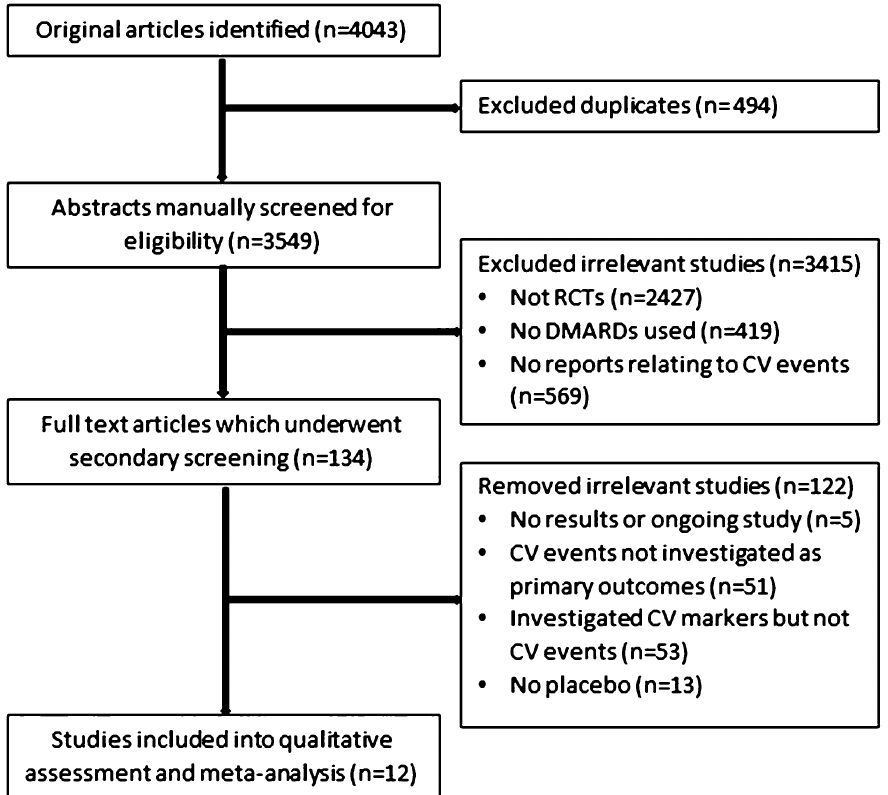
Figure 1. Preferred Reporting Items of Systematic Review and Meta-analyses (PRISMA) flow diagram. A total of 4043 studies were screened and 12 Randomized trials were included for